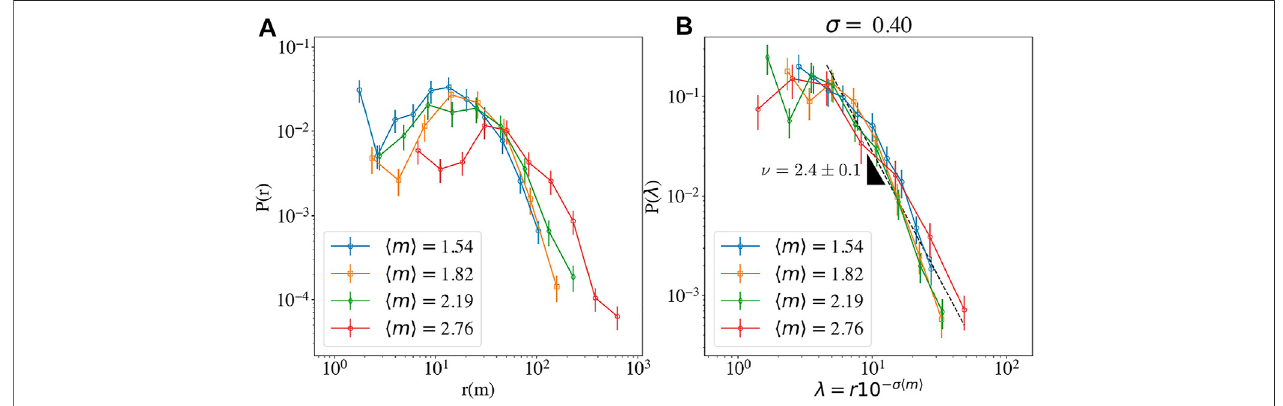
FIGURE 9 | (A) Probability density function of spatial distances in meters between directly triggered aftershocks and their mainshocks for different ranges of mainshockmagnitudes. (B) Probability density function ofspatial distances betweendirectlytriggered aftershocks and theirmainshocks(for r > 10 m ),where afactor of 10 − σ 〈 m 〉 rescales the distances (in meters) with σ =